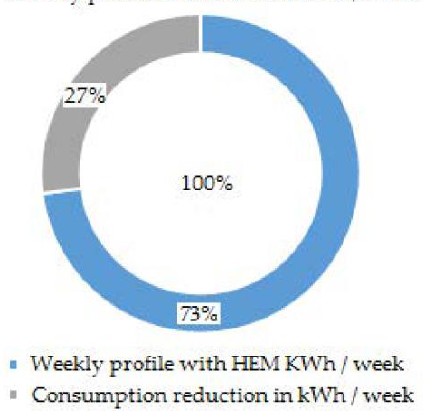
Figure 8. Impact of HEM usage in energy consumption.